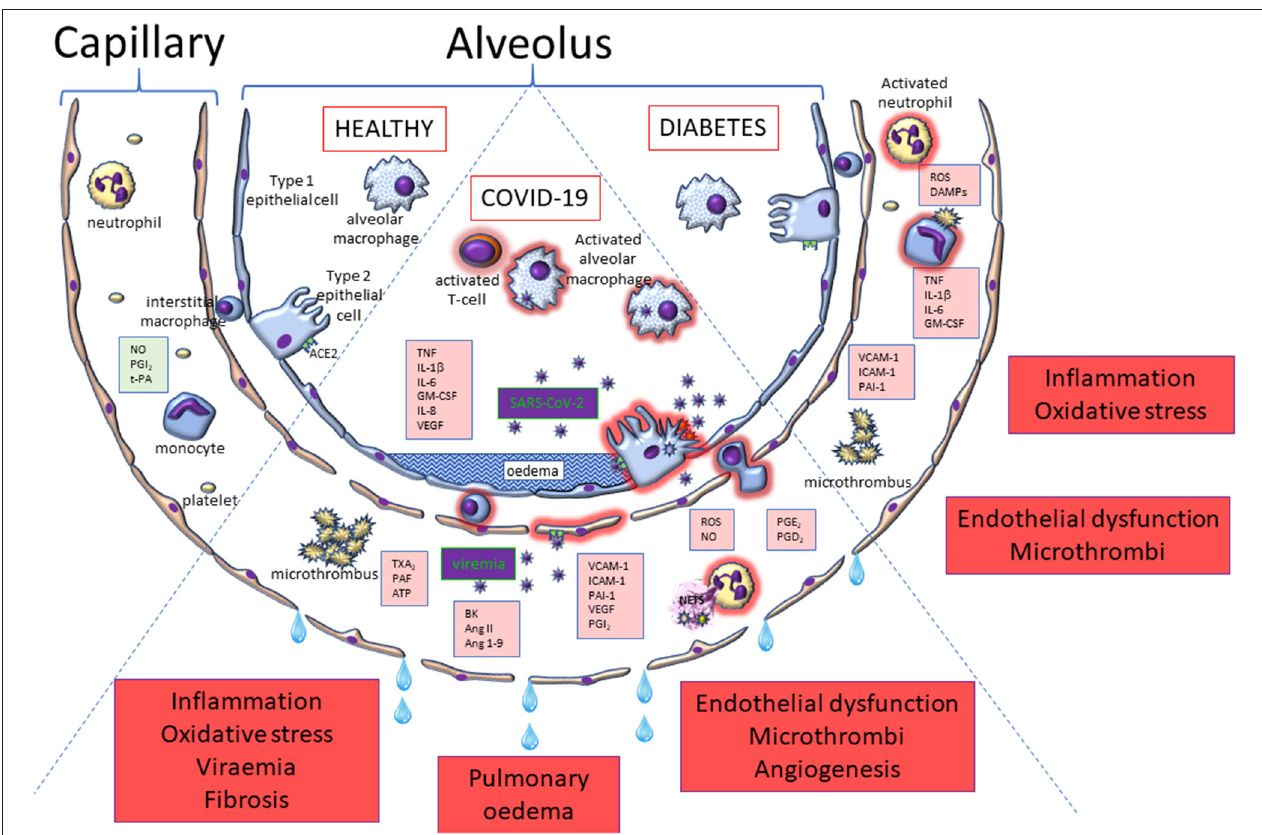
FIGURE 7 | Alveolar and capillary pathophysiology relevant to COVID-19 and diabetes compared to the healthy scenario. This figure highlights some of the key cells that become activated in COVID-19 (middle segment) and diabetes (right segment) that have the potential to drive dysfunction in endothelial (diabetes and COVID-19) and alveolar epithelial (COVID-19 only) cells. The pathophysiological consequences are highlighted in the red boxes.